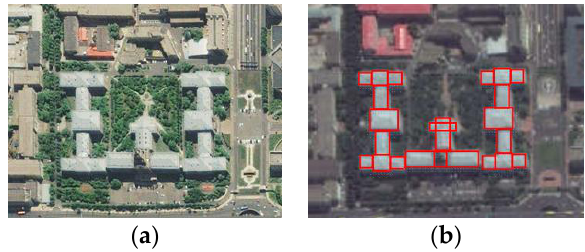
Figure 2. Examples of four types of buildings. ( a ) The four buildings; ( b ) Edge-lines of the roofs.